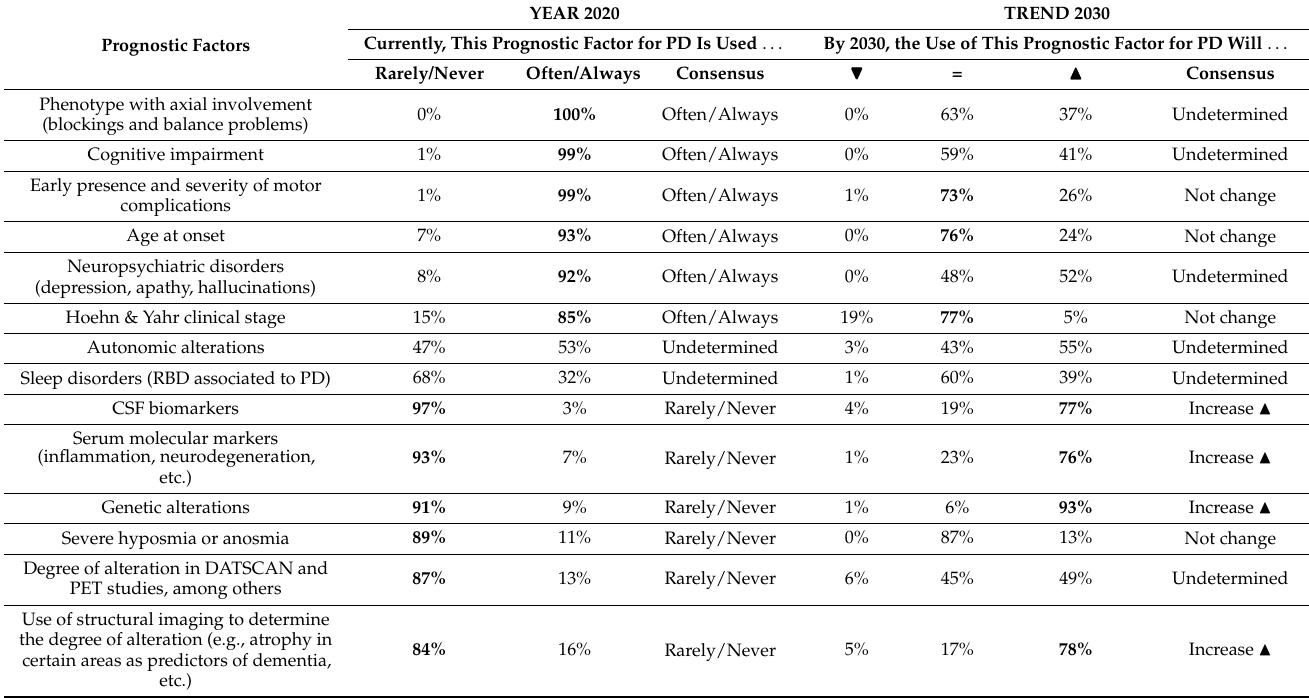
Table 1. Prognostic factors: present and future (consensus after both